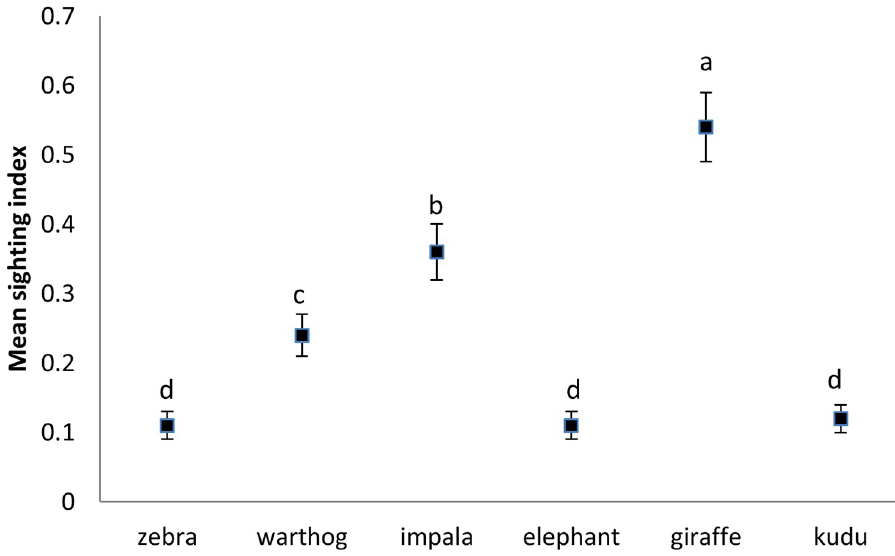
Fig 7. Mean ( ± SE) sighting index for six wildlife species. Similar letters show that there were no significant differences between the